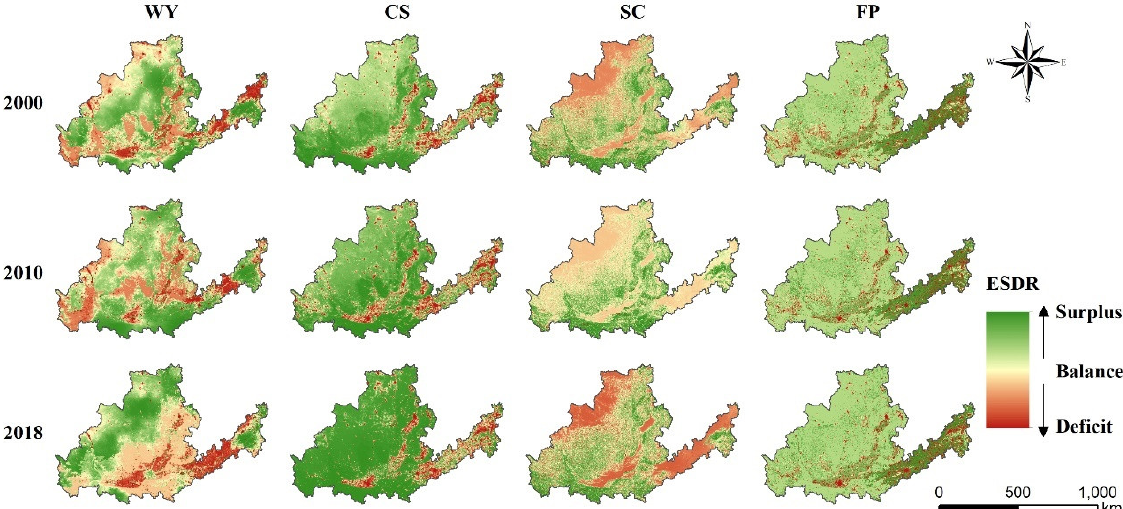
Figure 5. Spatial pattern of the ecosystem service supply-demand ratio in the Yellow River Basin in 2000, 2008, and 2018.